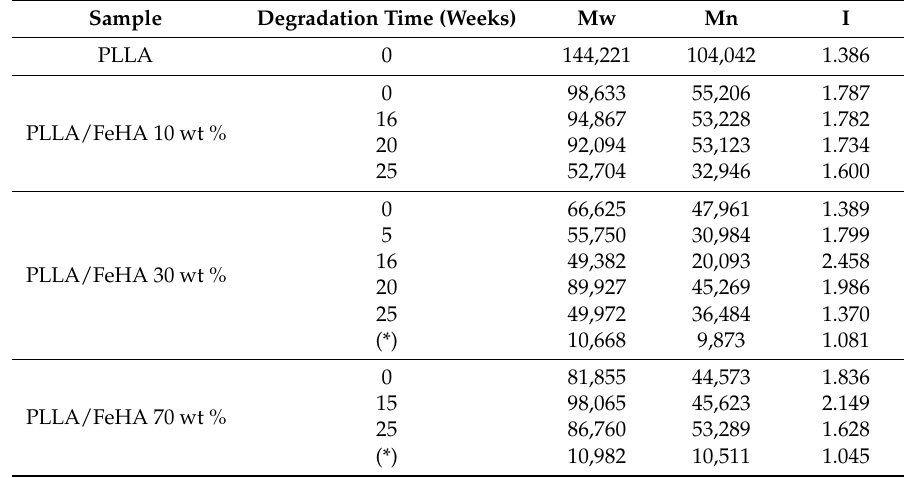
Table 3. Molecular weight: weight average (Mw), number average (Mn), and polydispersity index (I) of the PLLA/FeHA